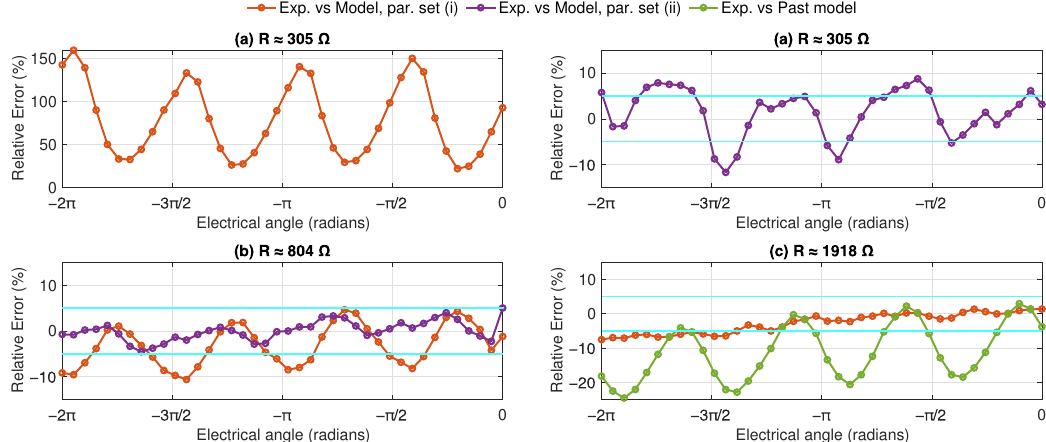
Figure 10. Relative error for both model parameter sets on the performed experiments. Error relative to past model also presented for experiment (c). Cyan-colored lines indicate ± 5%